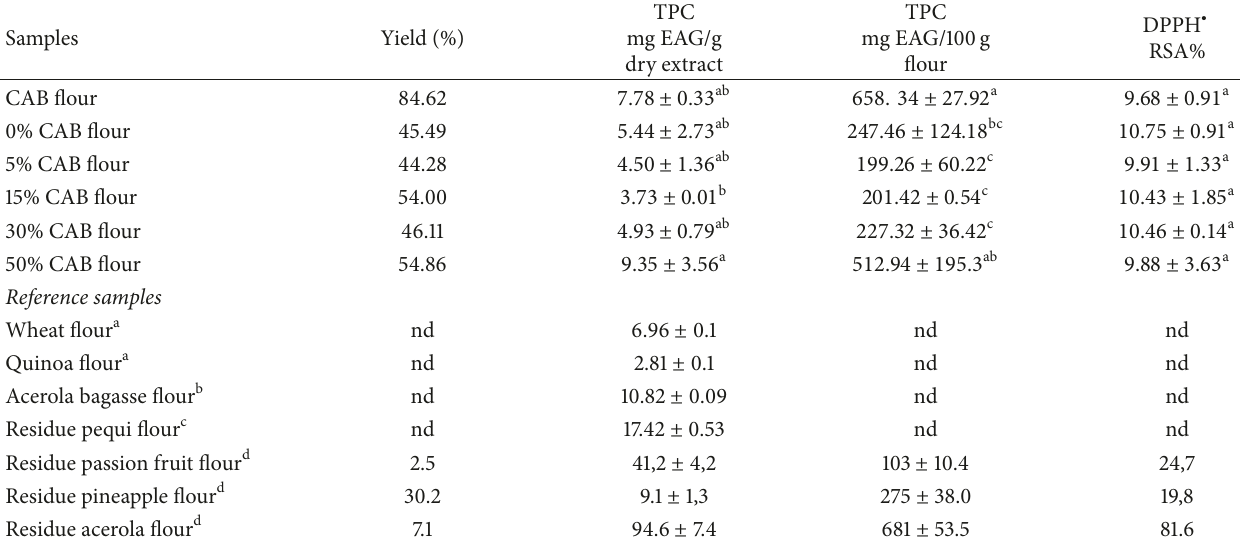
Table 4: Total content of phenols and DPPH ∙ radical of the hydroethanolic extracts of the CBA flour and cookies with 0%, 5%, 15%, 30%, and 50% of the CBA flour and fruit residues flours as